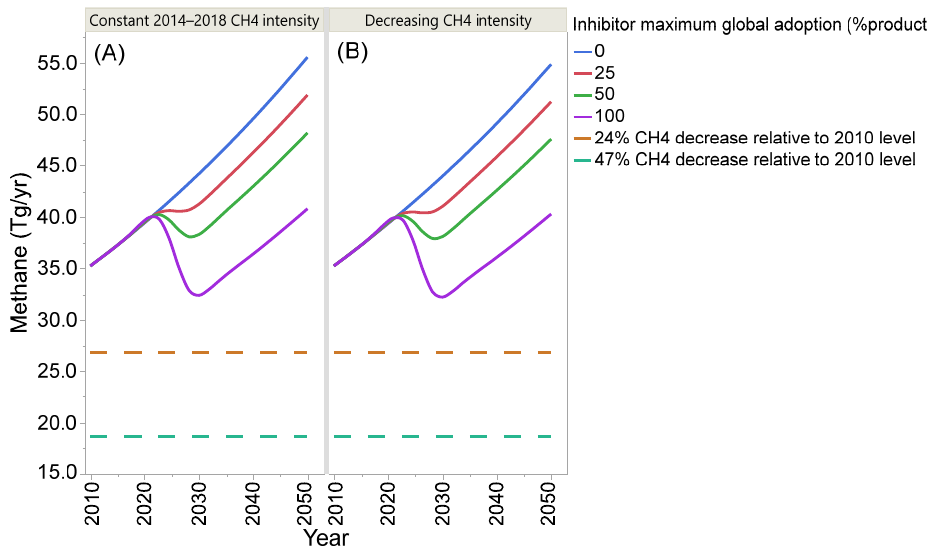
Figure 1. Predicted evolution of enteric methane (CH 4 ) emissions from global beef production between 2010 and 2050 considering ( A ) constant CH 4 intensity and ( B ) declining CH 4 intensity according to Table 1. Adoption of feed additive inhibitors of methanogenesis decreasing CH 4 intensity by 26.6% is simulated to occur at 0, 25, 50, or 100% of global beef production. Decreases in enteric CH 4 emissions of 24 and 47% relative to 2010 required to maintain a global temperature increase within 1.5 ◦ C according to different socioeconomic scenarios and climate models [15] are shown in dashed